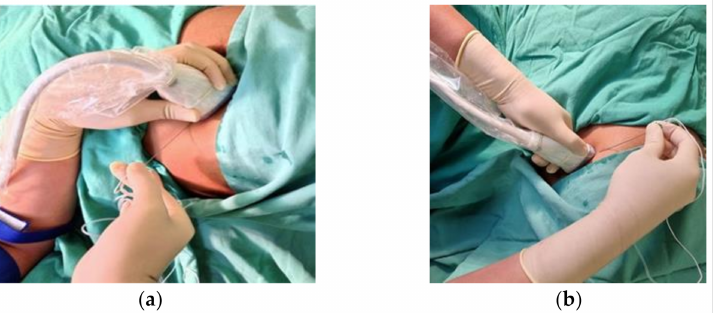
Figure 7. ( a ) Improper wrist flexion position. ( b ) Improper wrist flexion and deviation position. A pinch grip on the probe increases the forearm muscle strain, while a palmar grip is firmer but with less strain [29] (Figure